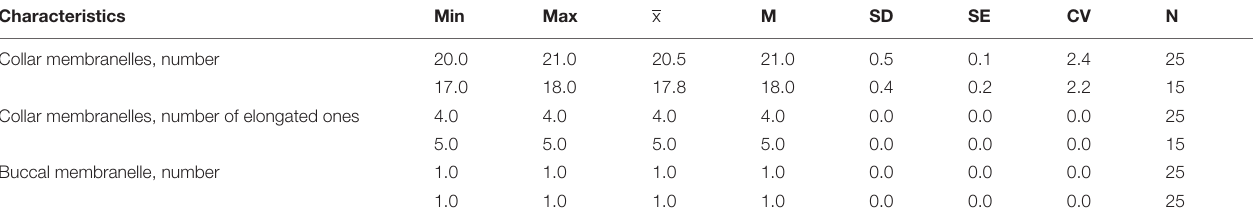
Frontiers in Marine Science |